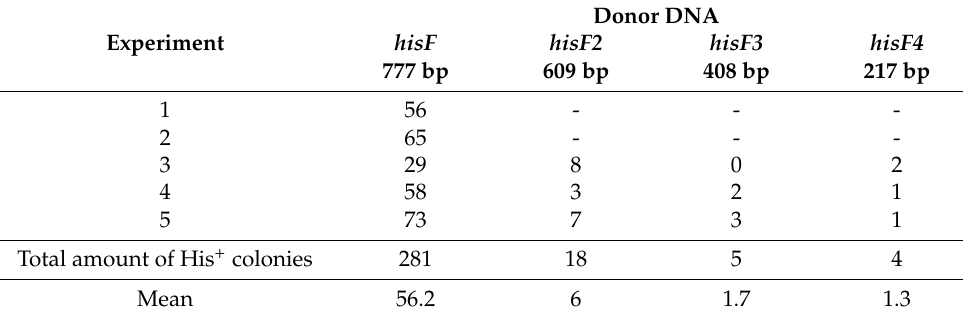
Table 2. Total number of His + colonies obtained per experiment.